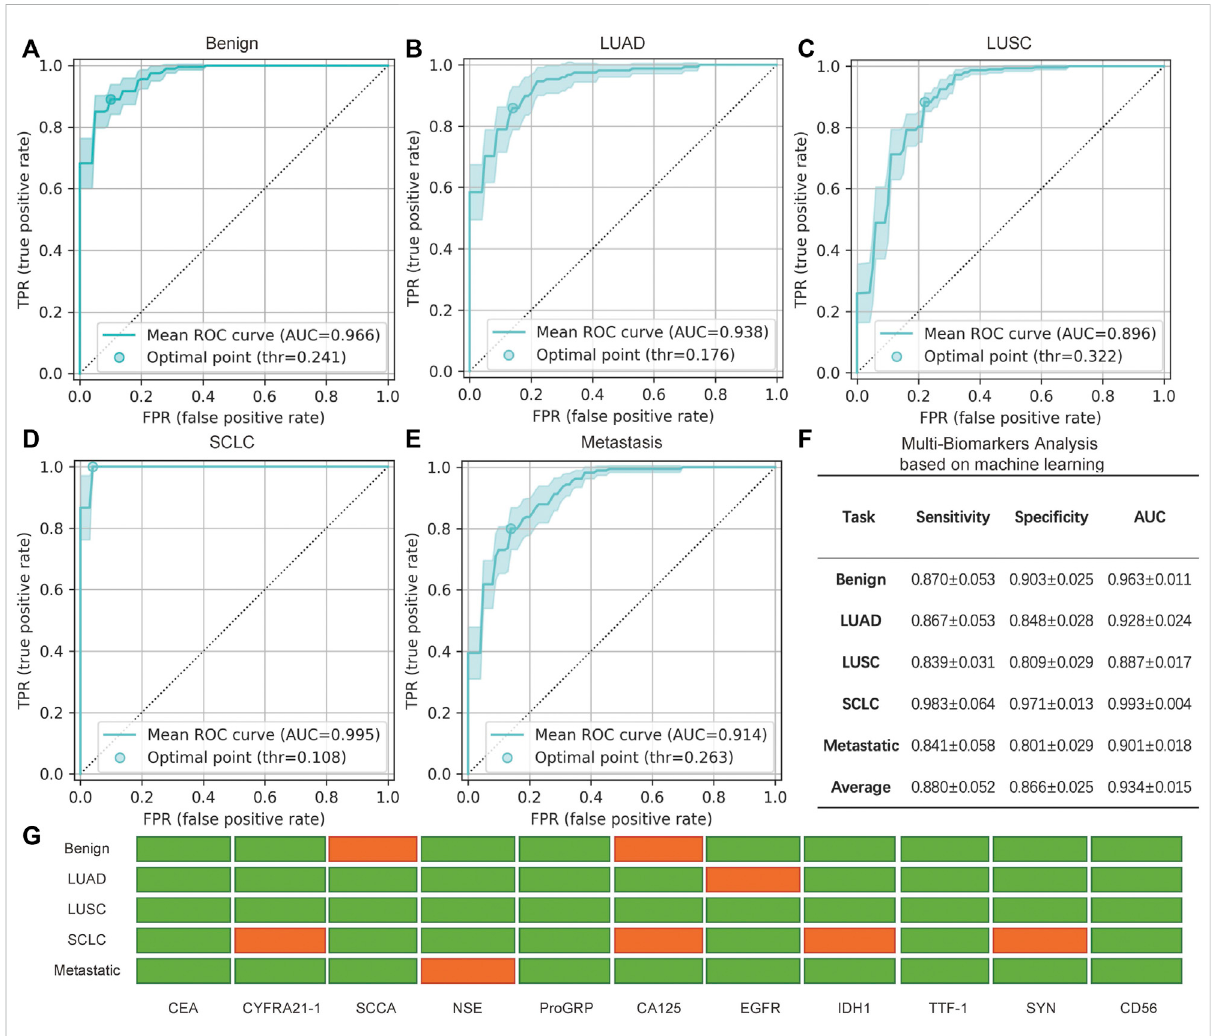
FIGURE 6 Analysis of the minimally invasive and rapid diagnostic method based on multiple biomarkers. (A – E) Mean receiver operating characteristic (ROC) curve with the 95% con fi dence interval (CI) and the optimal point for fi ve binary multi-biomarker classi fi cation tasks based on machine learning. (F) Speci fi c mean sensitivity, speci fi city, and AUC score for the fi ve tasks, in which ± indicates the 95% CI. Note that the values in F are averages of all values with different optimal points of every cross-validation experiment and differ from the mean ROC curves in (A – E) that are averagedbasedonallcurves. (G) Selected(green)andrejected(red)biomarkersgeneratedbythefeatureselectionmoduleviarecursiveelimination. The selected biomarker features were fed into the feature transformation and the classi fi er modules to build the fi nal